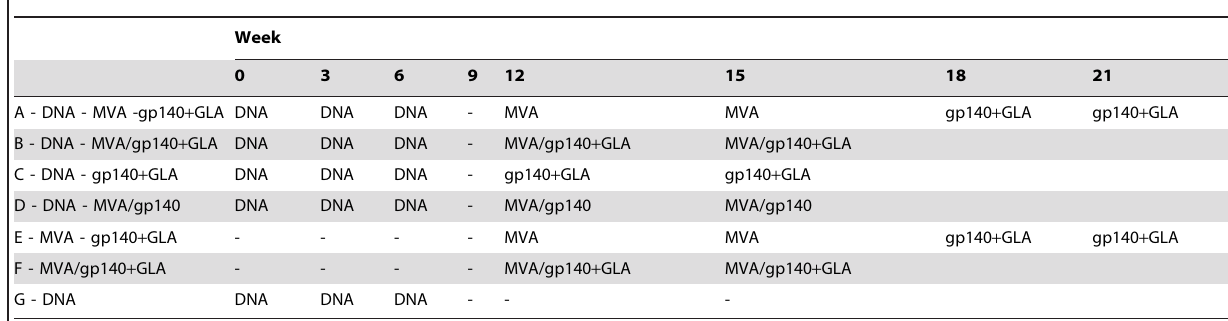
Female BALB/c mice received immunizations at three week intervals either sequentially or in combination into different quadricep muscles. doi:10.1371/journal.pone.0084707.t001 PLOS ONE |